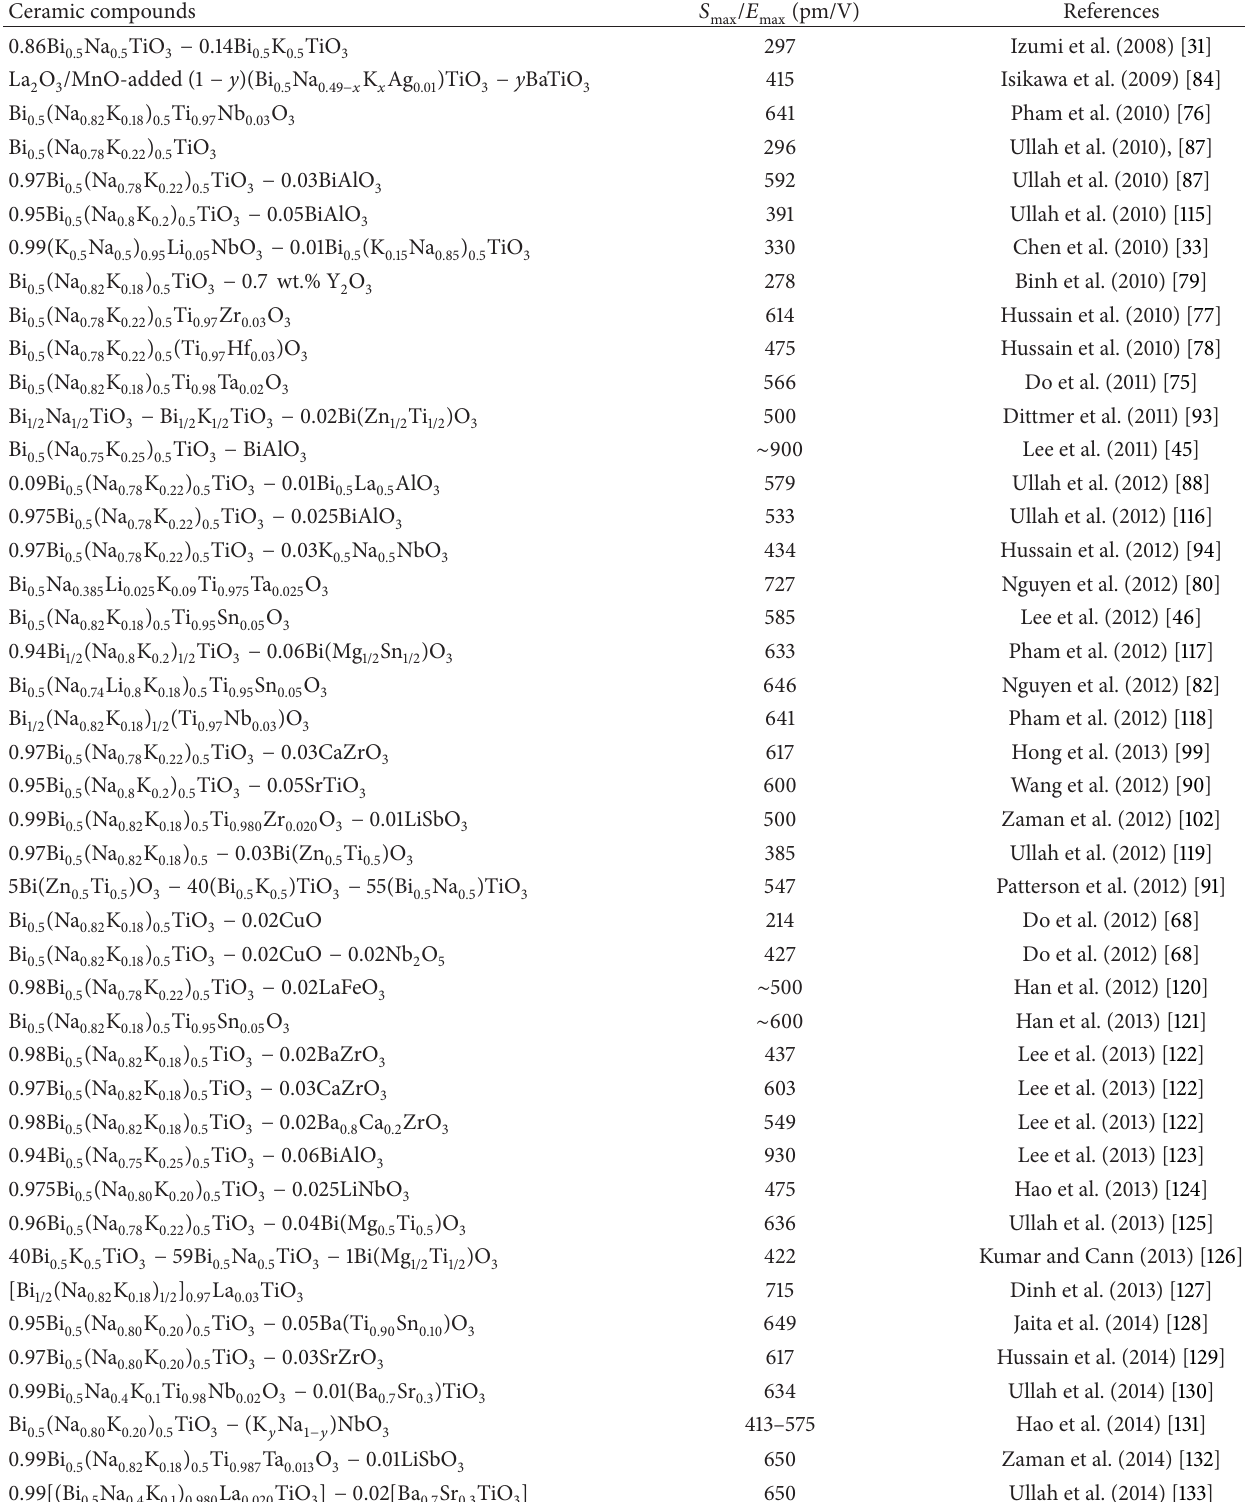
Table 1: The detailed composition of BNKT-modified ceramics with highest electric-field-induced strain. Ceramic